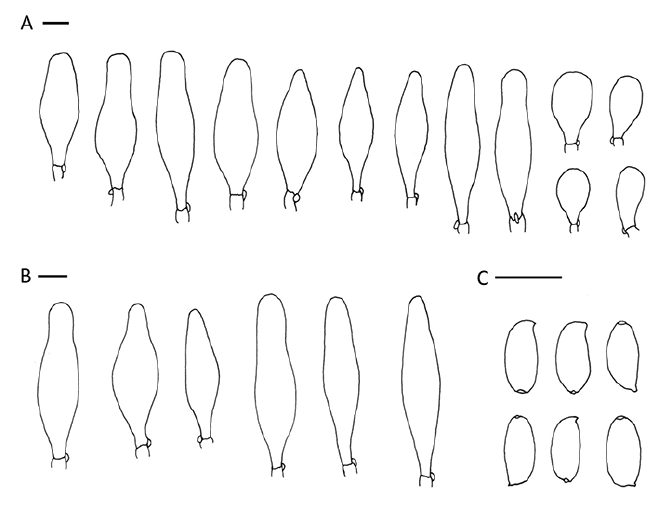
Figure 5 Microcharacters of Psathyrella bipellis (Quél.) A. H. Sm.: ( A ) cheilocystidia; ( B ) pleurocystidia; ( C ) spores. Scale bars: 10 µ m.